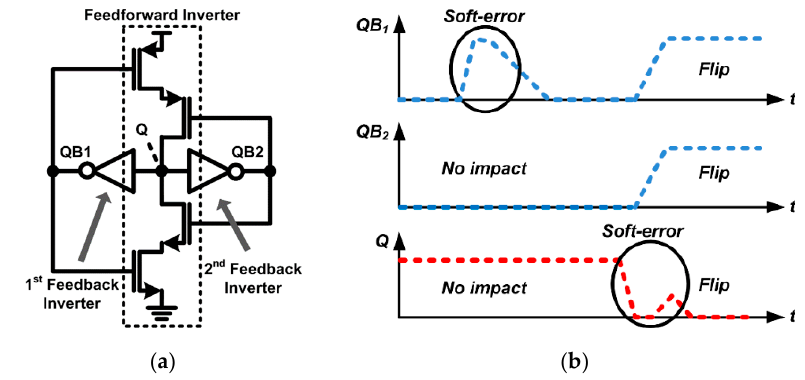
Figure 5. ( a ) Conventional dual feedback latch, ( b ) Timing diagram when the soft error occurs.